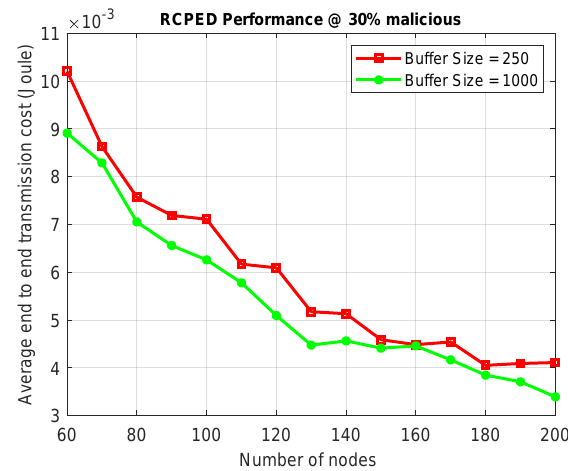
Figure 10. RCPED performance with different buffer